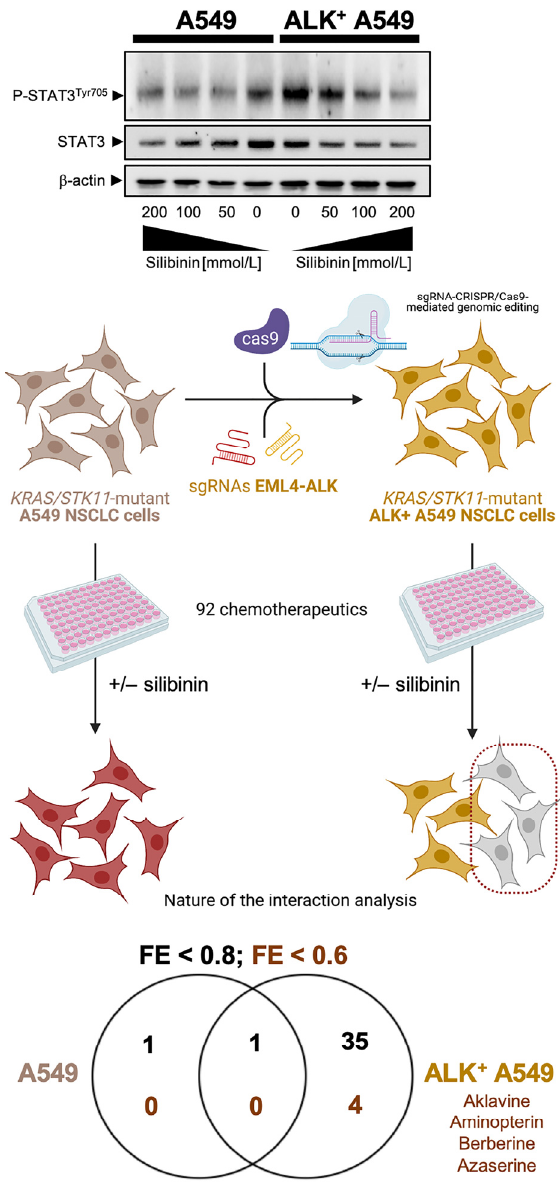
Figure 2. EML4-ALK-dependent chemosensitizing effects of silibinin in non-small cell lung cancer cells. We utilized the Phenotypic Microarray system, marketed and sold by Biolog (www.biolog.com, access date: 30 May 2021) to measure the sensitivity of an A549 non-small cell lung cancer (NSCLC) cell line with an EML4-ALK fusion isogenic oncogene (https://www.nature.com/articles/d42473-019-00011-z, access date: 30 May 2021) to a variety of growth inhibitors (in total, 92) in